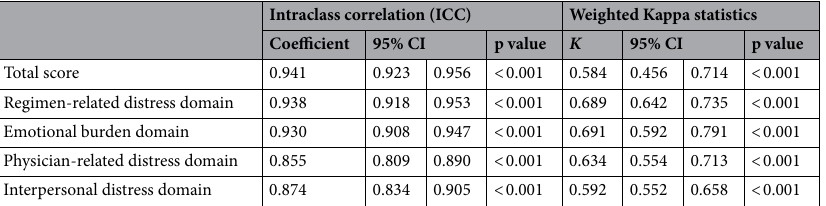
Table 4. Test retest reliability and agreement of the scale across two administrations at 4-weeks interval (n = 201). Interclass correlation coefficient and Kappa statistics are generated along with the 95% CI and p value for total score ad for all 4 domains